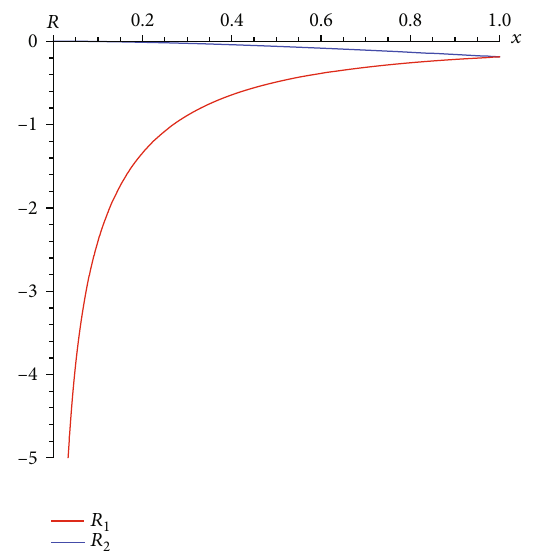
ffiffiffi p 6 π 2 α 3/2 = 2